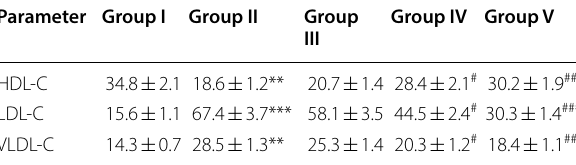
Table 2 Protective effect of T. portulacastrum extract on lipid profile in streptozotocin induced diabetic rats